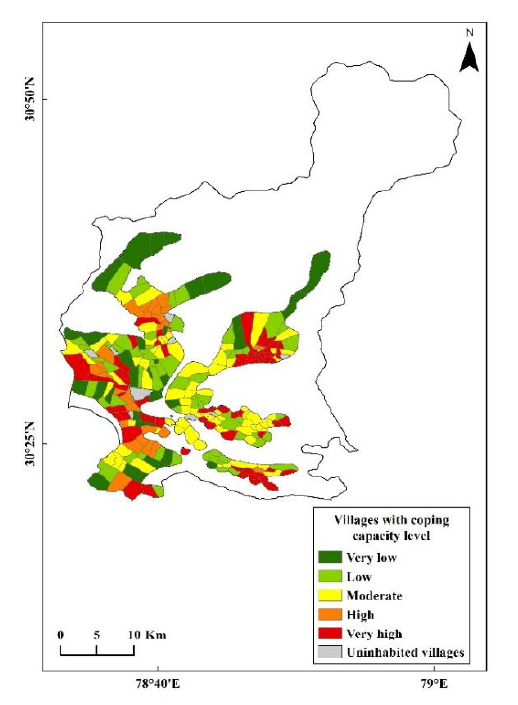
Figure 3. Coping capacity index distribution across the